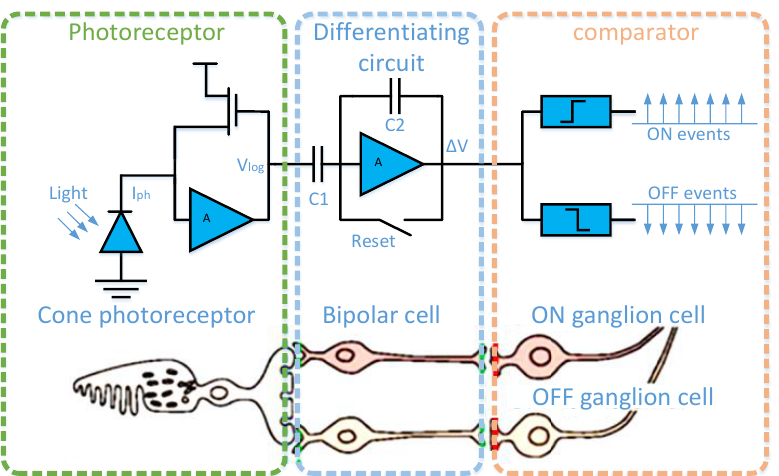
Figure 1. Three-layer model of a human retina and corresponding event camera pixel circuitry. The first layer is similar to retinal cone cells for photoelectric conversion; the second layer, similar to bipolar cells in the retina, is used to obtain changes in light intensity; the third layer is similar to the ganglion cells of the retina for outputting the light intensity change sign.